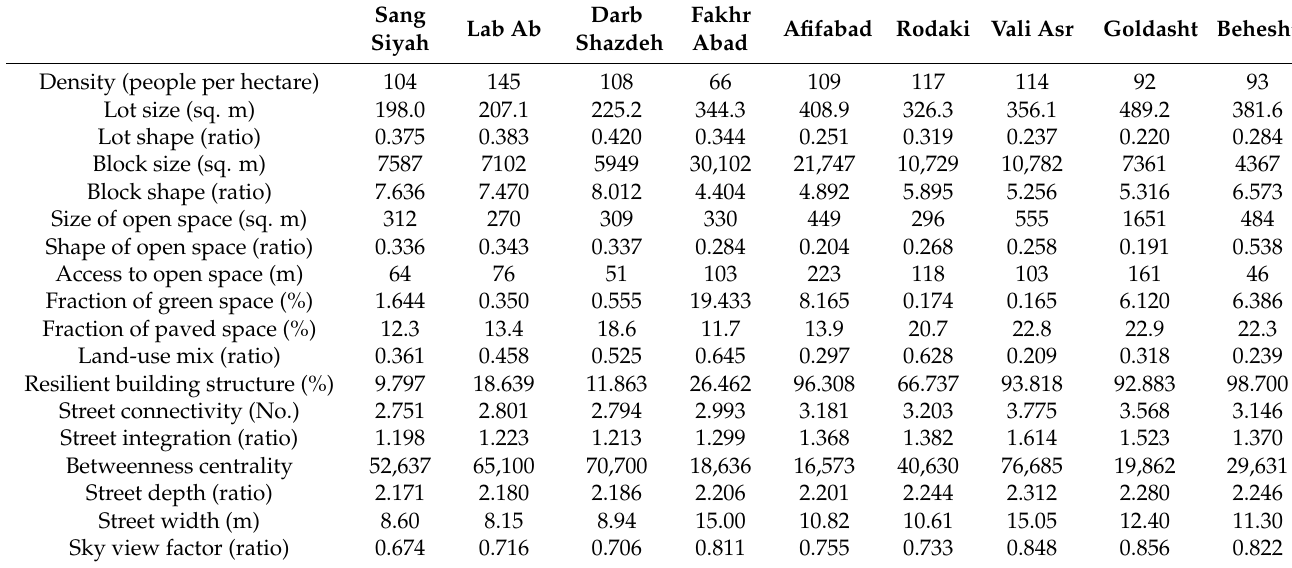
Table 3. Urban form resilience indicators for each neighborhood.